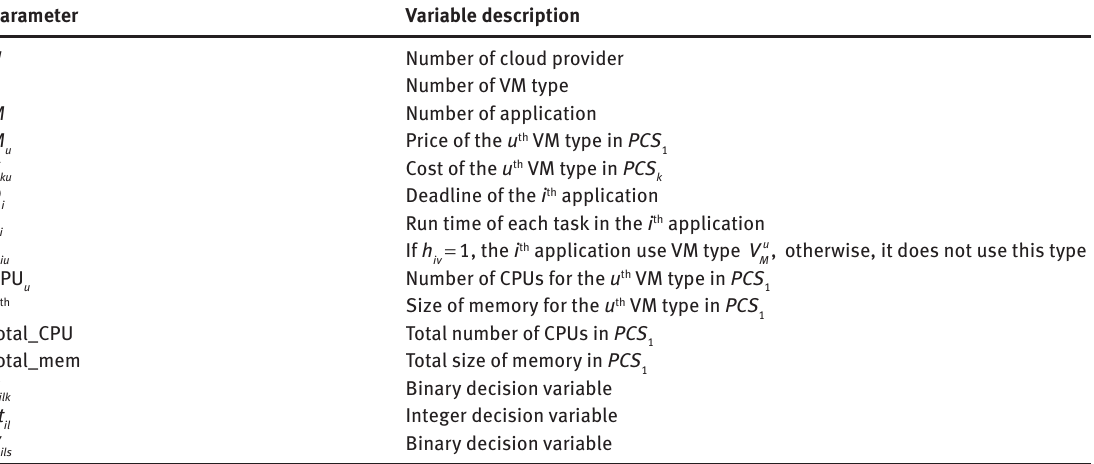
Table 1: The Parameters used in Problem Definition.